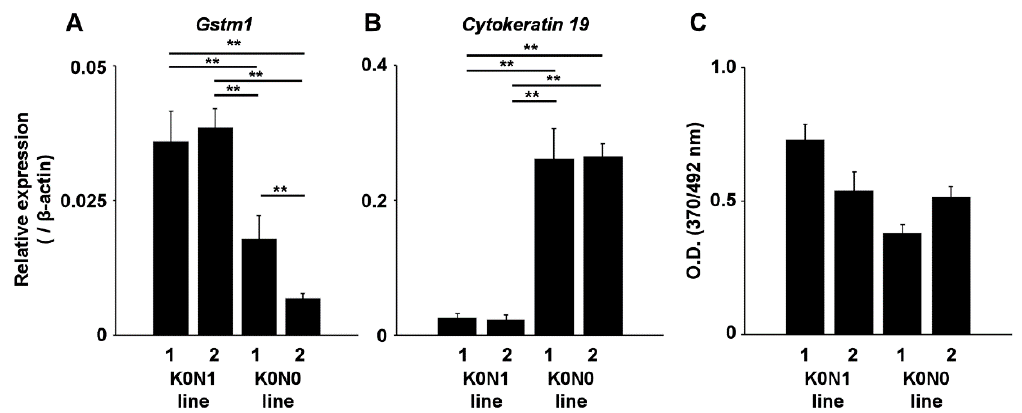
Figure 2. Real-time RT-PCR for checking the expression of Gstm1 ( A ) and Cytokeratin 19 ( B ) in K0N1 and K0N0 cell lines ( N = 4). ** indicates p < 0.01 by the Tukey–Kramer method. ( C ) BrdU assay in K0N1 and K0N0 cell lines following culture for 24 h in normal growth medium ( N = 6). The error bars show standard deviations.